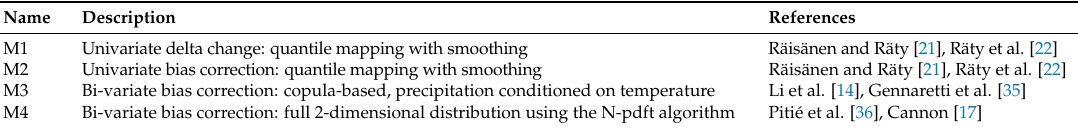
Table 3. List of bias adjustment methods used in this study together with a short